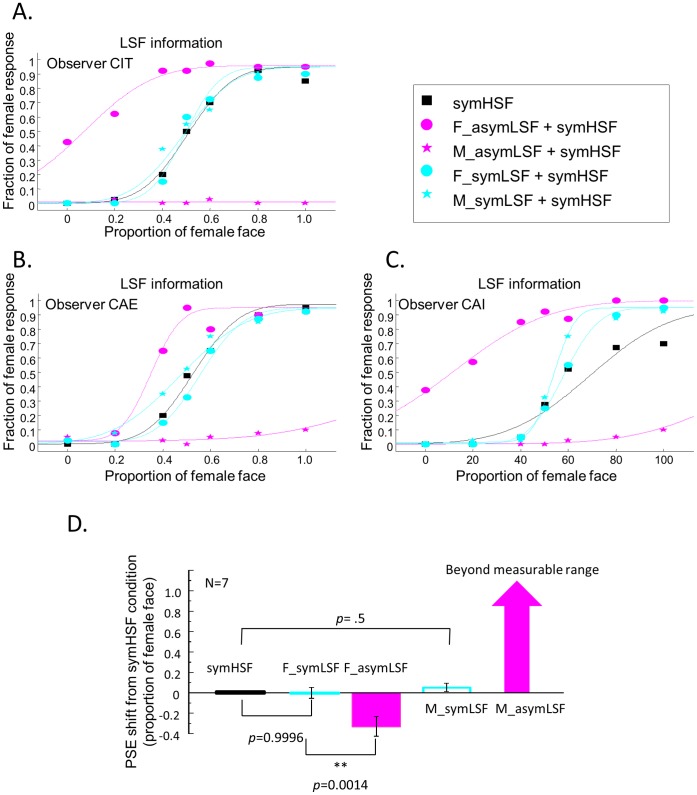
Comparisons of the effect of the asymLSF and symLSF information on face discrimination.A-C, Psychometric functions from three naïve observers. The fraction of “female face” responses is plotted as a function of the proportion of female face. Black curves: symHSF-only condition in the corresponding observers. Cyan curves: symLSF+symHSF in the female and male conditions. Magenta curves: asymLSF+symHSF faces. The symLSF component had very little influence on face discrimination, as indicated by the fact that the psychometric curves are not significantly shifted. D, The average PSE shifts relative to the symHSF-only condition. Other conventions as in Figure 3.